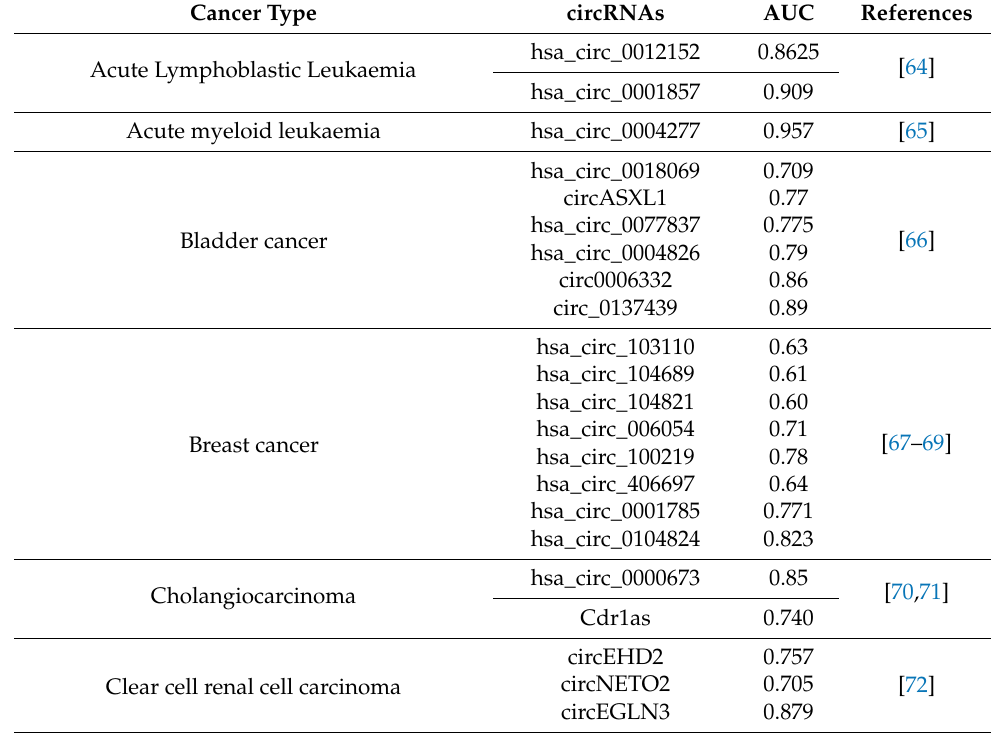
Table 2. CircRNAs in